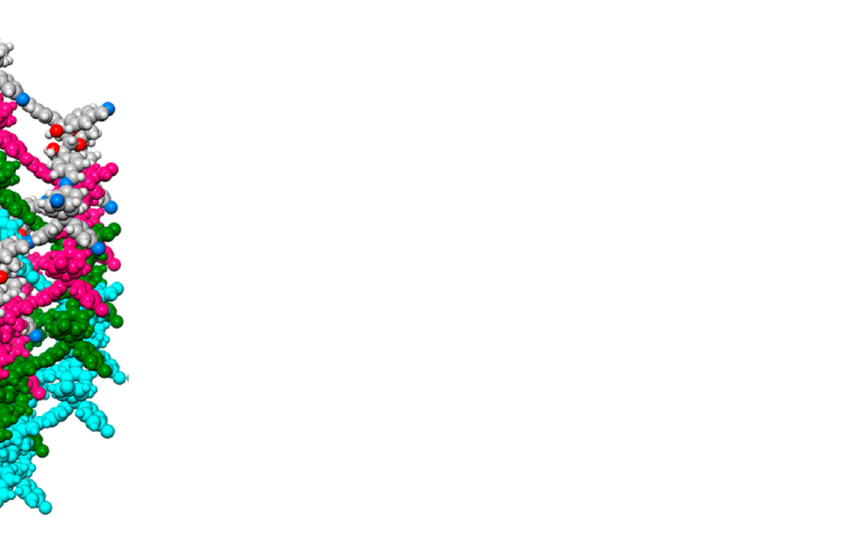
Figure 16. The structure of SP-3D-COF-1. Reprinted (adapted) with permission from [56]. Copy- right 2018 American Chemical Society. In another study [58], a 3D COF (3D-HNU5) was designed using azine as a linker by condensation of (tetrakis(4-formylphenyl)-methane) and hydrazine in an ionic liquid [Bmim][Tf 2 N] (1-butyl-3-methylimidazolium bis((trifluoromethyl)sulfonyl)imide) at am- bient temperature. The crystal possessed dia nets with a two-fold interpenetrated topol- ogy and is chemically and thermally stable. The crystal selectively absorbs carbon dioxide over nitrogen due to its porosity and narrow distribution of pore size. The skeleton was stable in the acidic solution but unstable in the alkaline solution as the reactions forming C=N gets reversed under alkaline conditions. Additionally, the crystal structure could not sustain very high alkaline and acidic conditions. The crystal was thermally stable even at 450 °C due to the existence of the conjugated and linear azine linker [59]. 3D-HNU5 con- tains excessive nitrogen atoms within the pores which lead to added Lewis acid–base in- teractions at low pressure and enhance the uptake of carbon dioxide. Moreover, the crystal